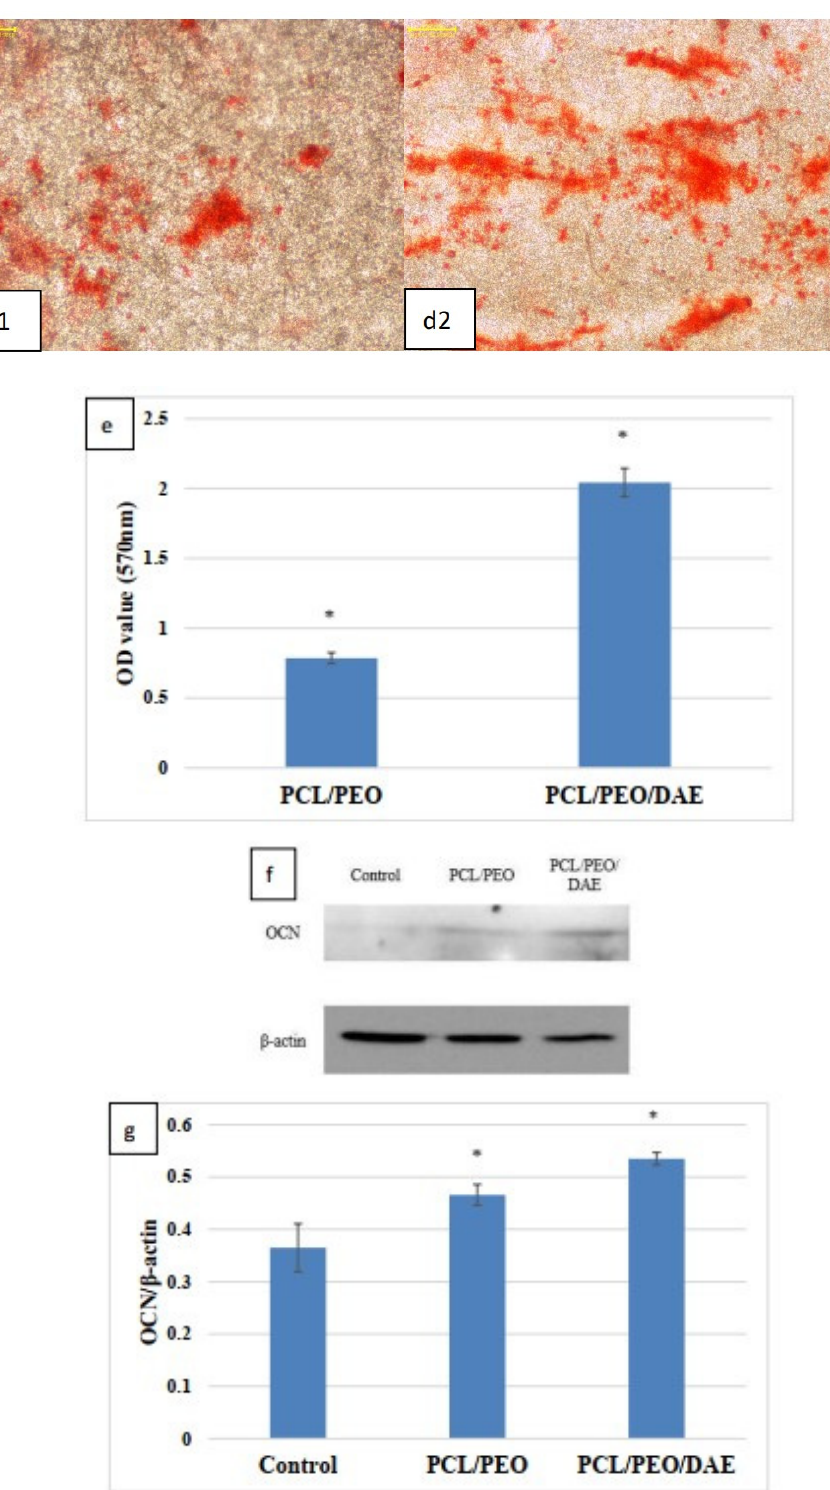
Figure 8. PDLSCs grown on the PCL/PEO ( a 1) and PCL/PEO/DAE nanofiber ( a 2) over two days of culture; scale bar = 100 µ m. Cell viability ( b ) * p < 0.05 for compared with culture day 1. Quantitative RT-PCR analysis of osteogenesis-related genes ( c ), Alizarin Red S staining of PDLSCs cultured on the PCL/PEO ( d1 ) and PCL/PEO/DAE nanofiber ( d2 ) over 21 days: scale bar = 100 µ m. The quantification ( e ), and western blotting ( f ) and quantification ( g ) of PDLSCs cultured on the nanofibers treated with 500 µ g/mL DAE. Values are expressed as mean ± SD (n = 3), * p < 0.05 compared with